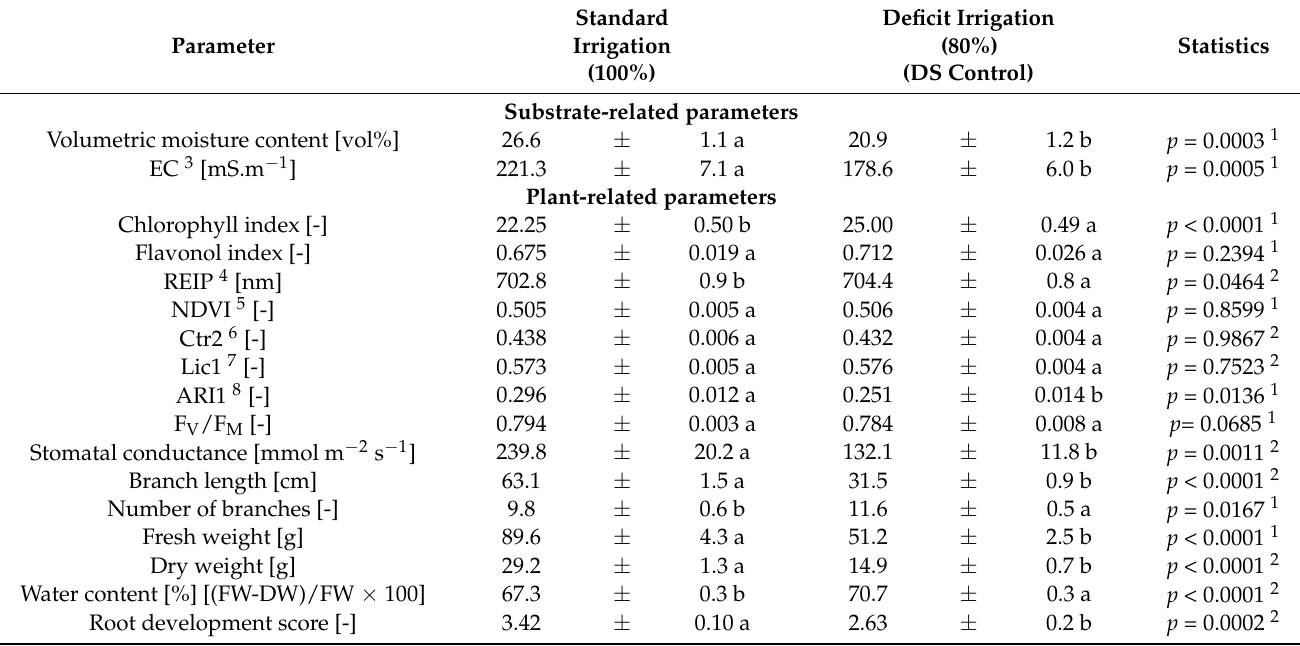
Table 3. Effect of deficit irrigation (trial 2019) on the substrate- and plant-related parameters of Hydrangea compared with a standard irrigation treatment. The average of each parameter over the trial is presented ± SE. Different letters (a and b) per parameter indicate a significant difference at p ≤